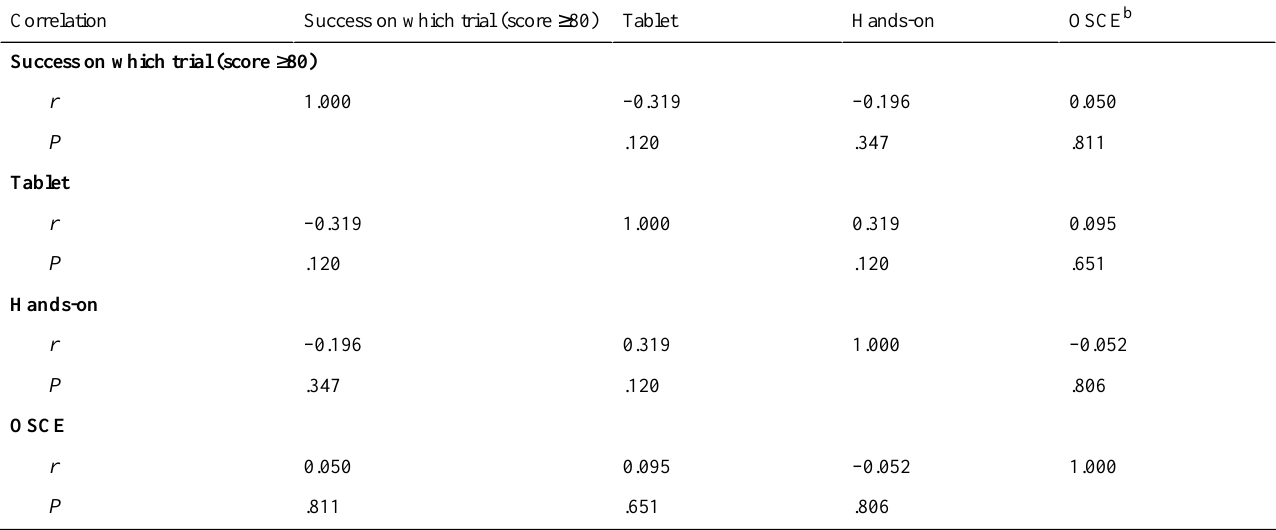
OSCE b Hands-onTabletSuccess on which trial (score ≥ 80)Correlation